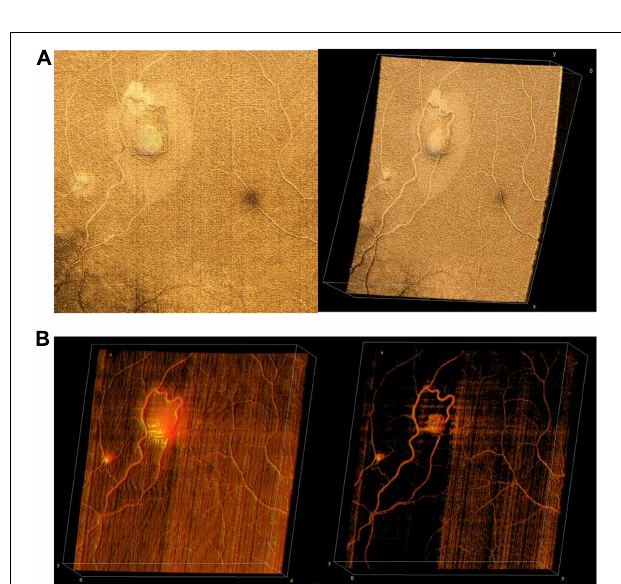
FIGURE 9 | Retinal hemangioblastomas in the setting of Von Hippel Lindau (VHL) syndrome. (A) Volume rendering of retinal hemangioblastomas in a 15-year-old. Left image shows an en face of a three-dimensional volume rendering of the tumors taken with a 40 ◦ FOV, while image on the right shows an angled view of the same volume. (B) Three-dimensional visualization of vessels generated from OCTA of the same volume as in panel (A) . The image on the left shows a three-dimensional rendering of the OCTA volume, showing flow signal within the tumors. Image on the right shows the same volume with higher contrast between vessels and surrounding